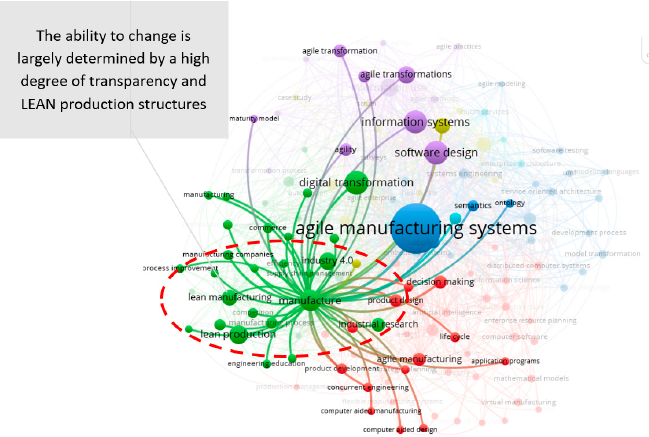
Figure 8. VOSviewer: One focus of agile manufacturing systems is digital transformation.